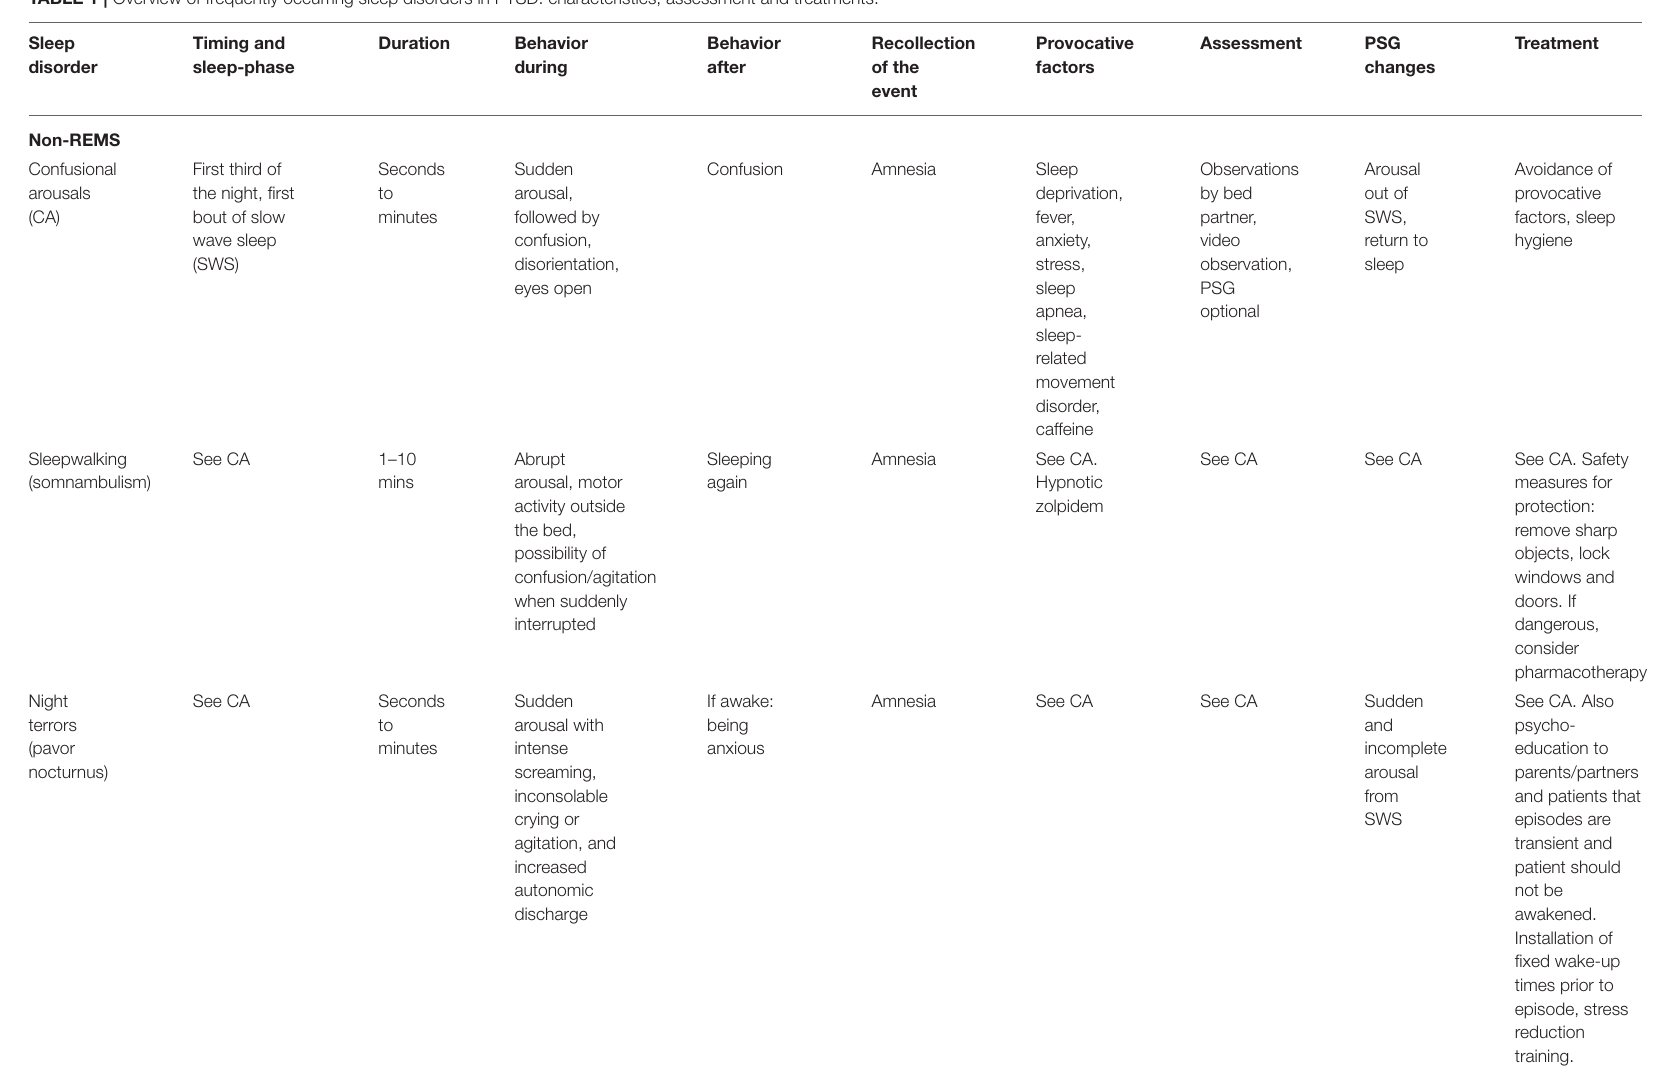
TABLE 1 | Overview of frequently occurring sleep disorders in PTSD: characteristics, assessment and treatments. Sleep Timing and disorder sleep-phase